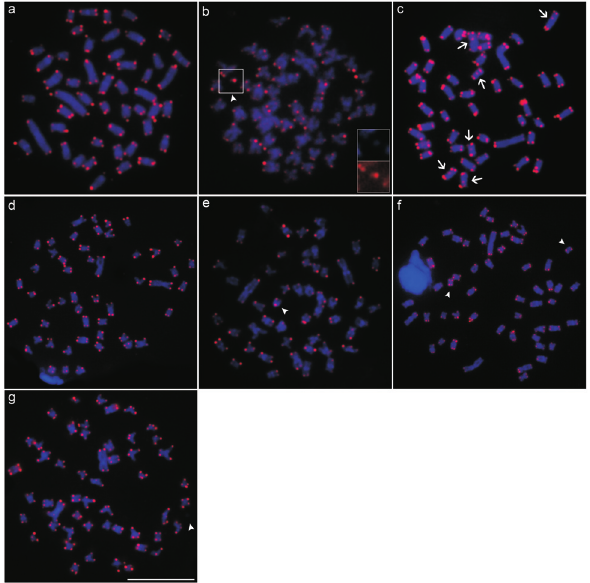
Figure 7 - Metaphases mapped by FISH with the telomeric probe (TTAGGG) n in: (a) M . cosmops ; (b) M . forestii ; (c) M . nigromarginata ; (d) Moenkhausia sp. n.; (e) M . oligolepis (Xapuri River); (f) M . oligolepis (Corredeira Stream), and (g) M . oligolepis (Sangue River). Interstitial sig- nals are indicated by the arrows, while the B chromosomes are shown by the arrowheads. Scale bar = 10 (cid:2) m.